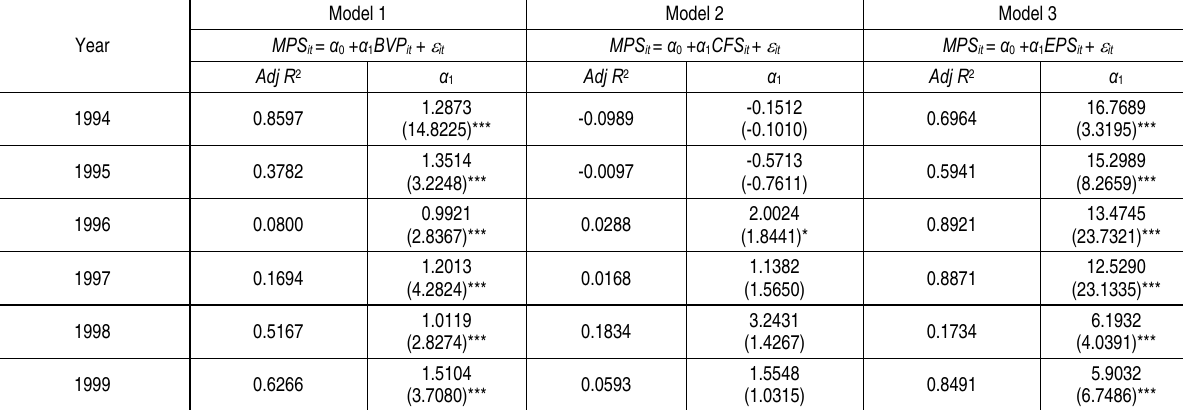
Table 4. Analyses of the value relevance of book value, earnings and cash flows: simple linear